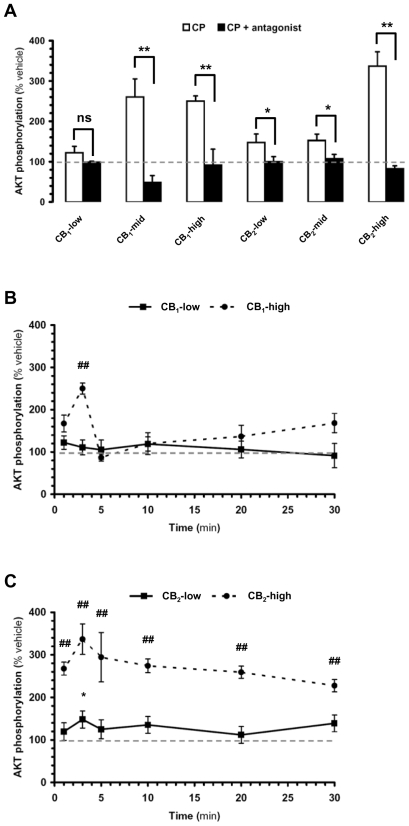
Activation of CB1 and CB2 receptors differentially increases AKT phosphorylation in DBT subclones.DBT subclones stably expressing cannabinoid receptors were expanded in 24-well plates, incubated with CP-55,940 (CP, 1 µM), and AKT phosphorylation quantified by Luminex multiplex immunoassay. (a) CB1- and CB2-expressing subclones were incubated with CP for 5 and 3 min, respectively (white bars). When testing the effect of antagonists, cells were pretreated with SR141716A (5 µM) and SR144528 (3 µM) added 10 min before CP (black bars). (b,c) Kinetics of CP-induced increase in AKT phosphorylation in CB1-low, CB1-high, CB2-low and CB2-high subclones. Data = mean±s.e.m. of 6 to 8 independent experiments expressed as % of vehicle (i.e. level of AKT phosphorylation when treated with vehicle, i.e. 0.1% DMSO. Please note that basal AKT phosphorylation did not vary significantly over time (Figure S1b). In (a), (*) = p<0.05 significantly different from the response in the presence of inhibitor, ANOVA followed by Bonferroni's post-test. In (b,c), (*) and (#) = p<0.05, and (**) and (##) = p<0.01 significantly different from vehicle at corresponding time point, ANOVA followed by Bonferroni's post-test. Non-significant (ns).